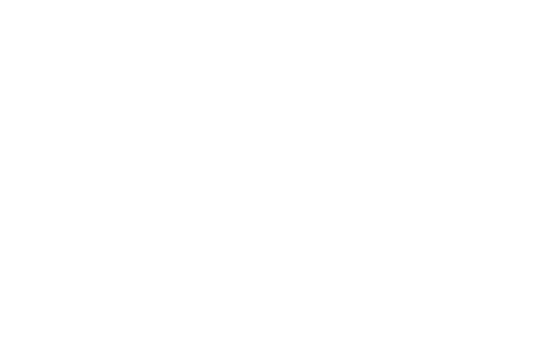
Table 2. Baseline subject